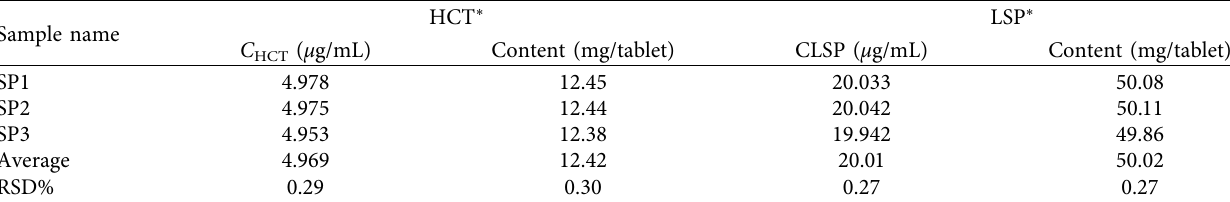
Table 2: Measured amounts of HCT and LSP in Splozarsin Plus tablet and the respective RSD values.